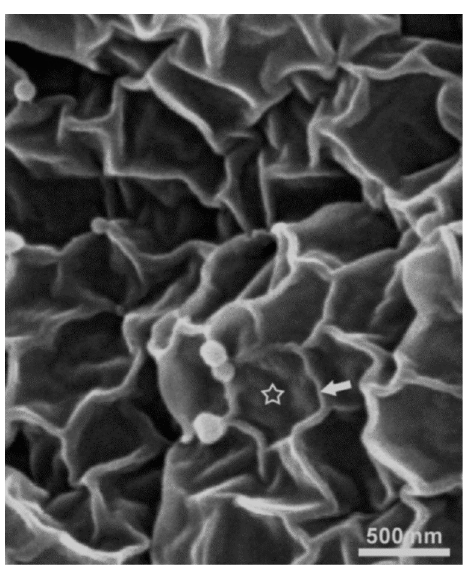
Figure 1. Apical plasma membrane of umbrella cell. The scalloped appearance is due to urothelial plaques (asterisk) of thickened membrane surrounded by hinge regions of normal membrane (arrow), as seen under the scanning electron microscope.